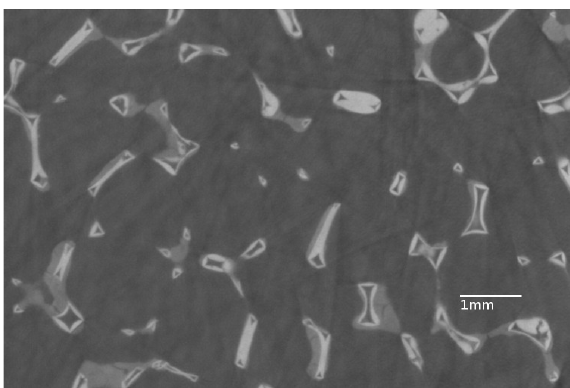
Figure 10. X-ray picture of Bi